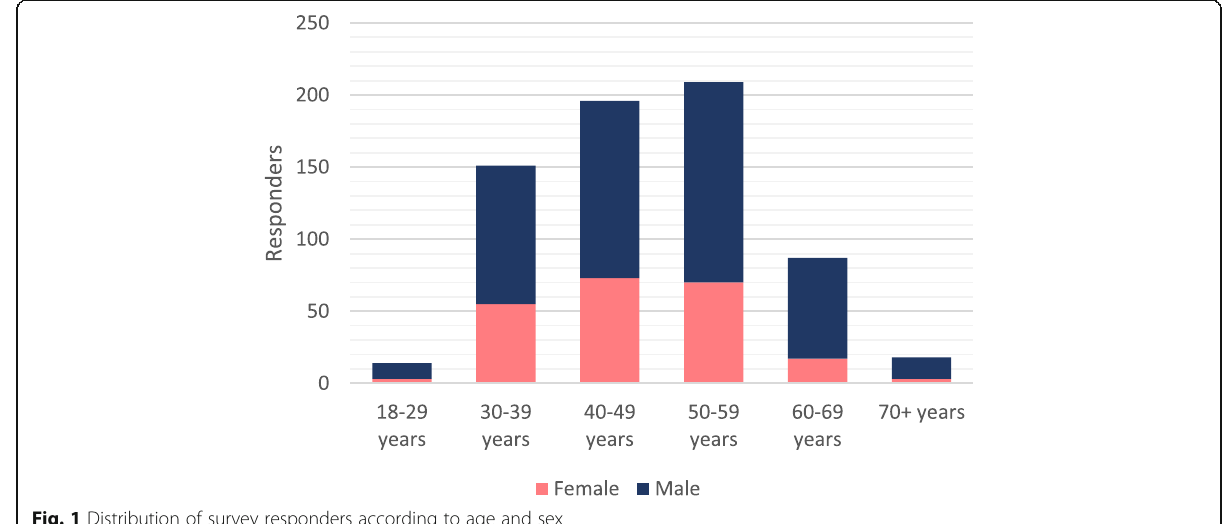
Fig. 1 Distribution of survey responders according to age and sex